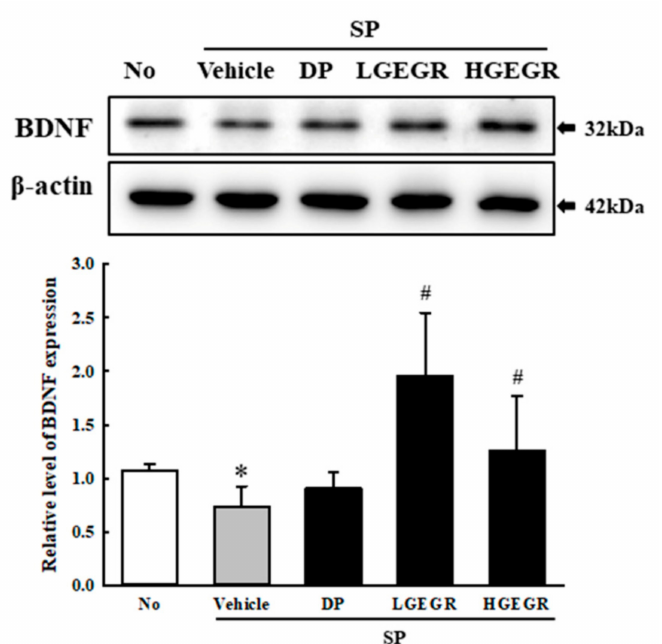
Figure 4. Secretion level of BDNF protein. Total tissue homogenates were prepared from brains of SP-injected mice treated with Vehicle or GEGR as described in Materials and Methods. Total protein (50 µ g per sample) was immunoblotted with antibodies for the BDNF protein. After determining the individual band intensity level using an imaging densitometer, the relative levels of the proteins were calculated based on the intensity of actin. Three samples were assayed in duplicate by western blotting. Data are reported as mean ± SD values. * p < 0.05 compared with the No treated group. # p < 0.05 compared with the SP + Vehicle treated group. Abbreviation: DP, donepezil; GEGR, gallotannin-enriched extract of Galla Rhois; SP,